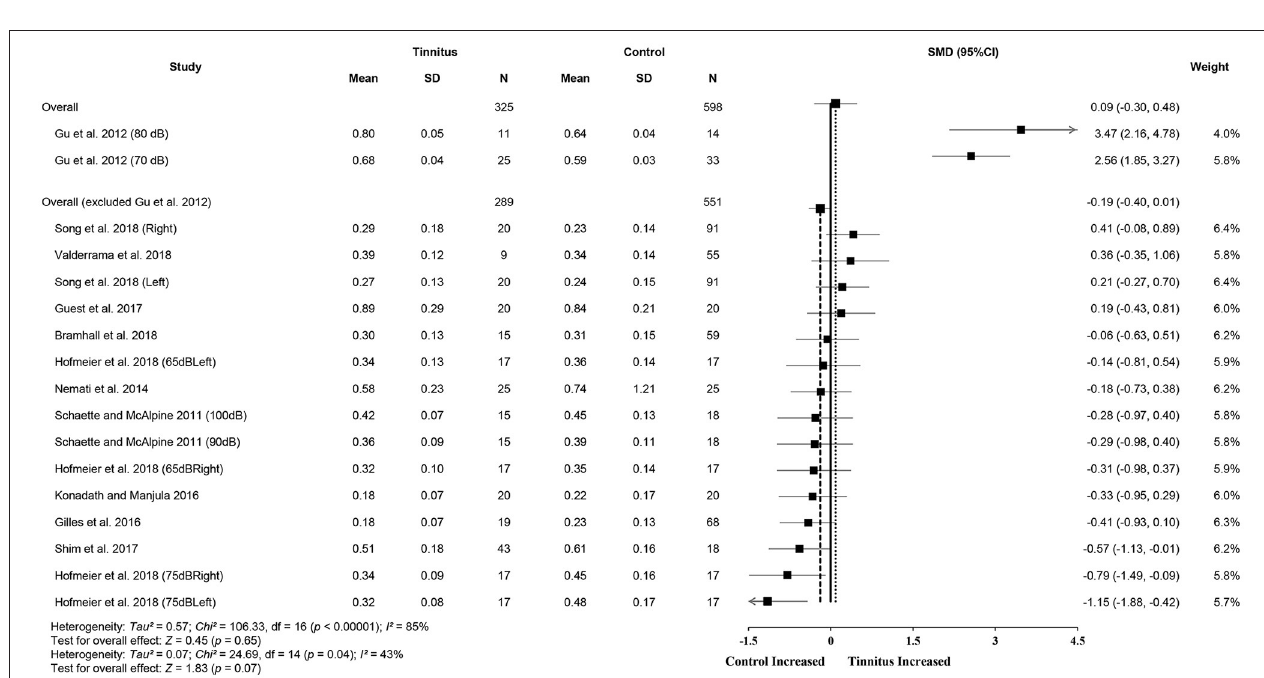
FIGURE 3 | Forest plot of 11 studies for the difference of wave I amplitudes (95% CI) between tinnitus and control participants.